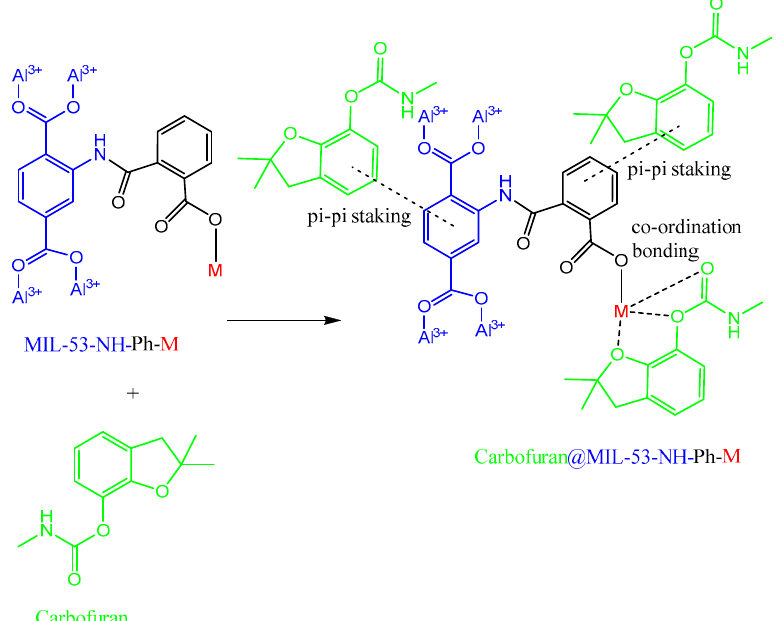
Figure 10. The proposed adsorption mechanism of carbofuran onto the modified MIL-53-MOFs.